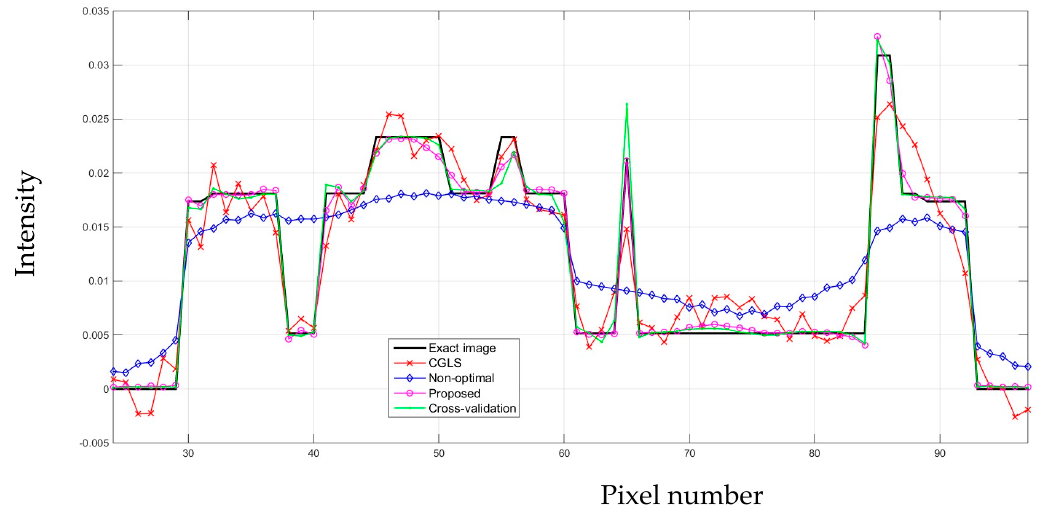
Figure 6. One-dimensional profiles of all the results from four cases, in comparison with the exact image.